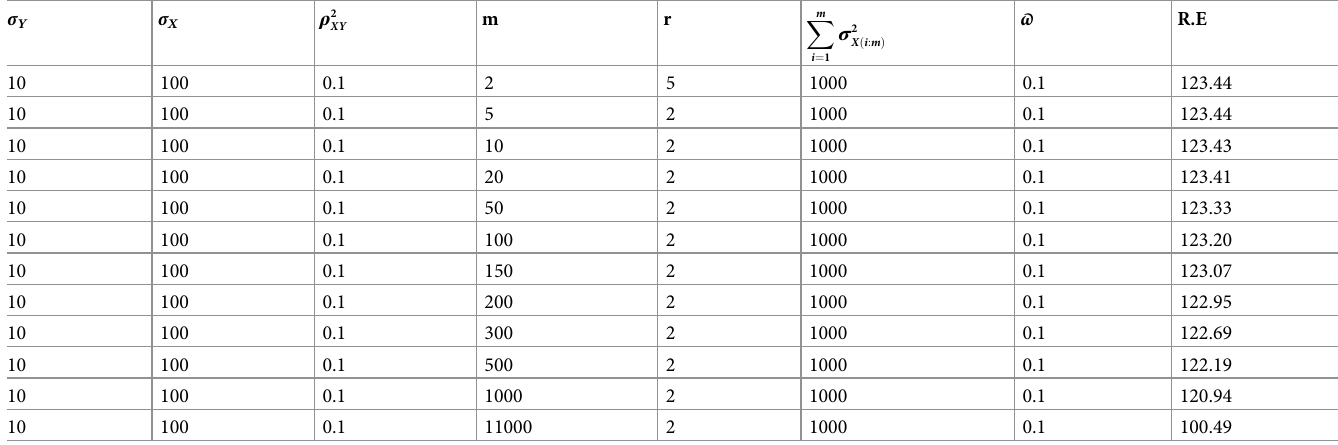
in comparison to ^ μ NGO : Disclosures